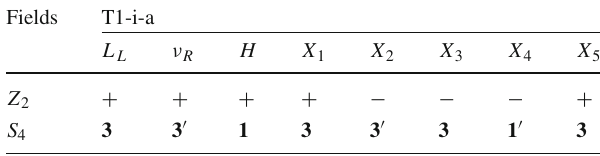
Table 3 Summary of the LQs that can accommodate the R K ( ∗ ) , R D ( ∗ ) , and/or ( g − 2 ) μ anomalies